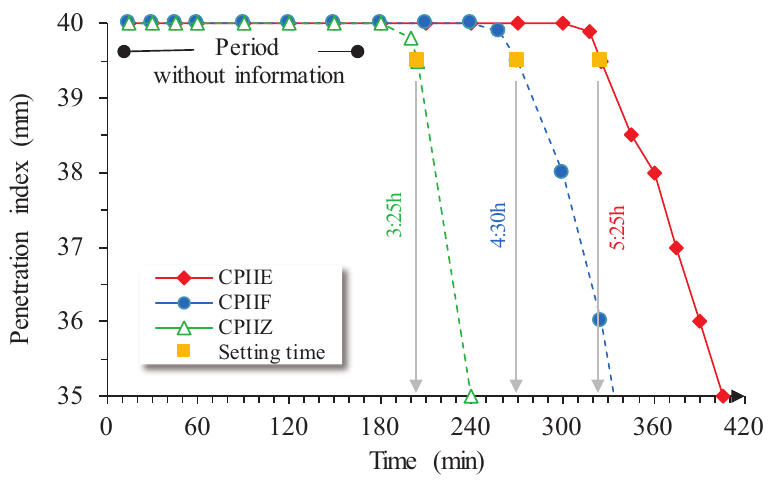
Monitoring of Vicat needle penetration for each suspension in function of